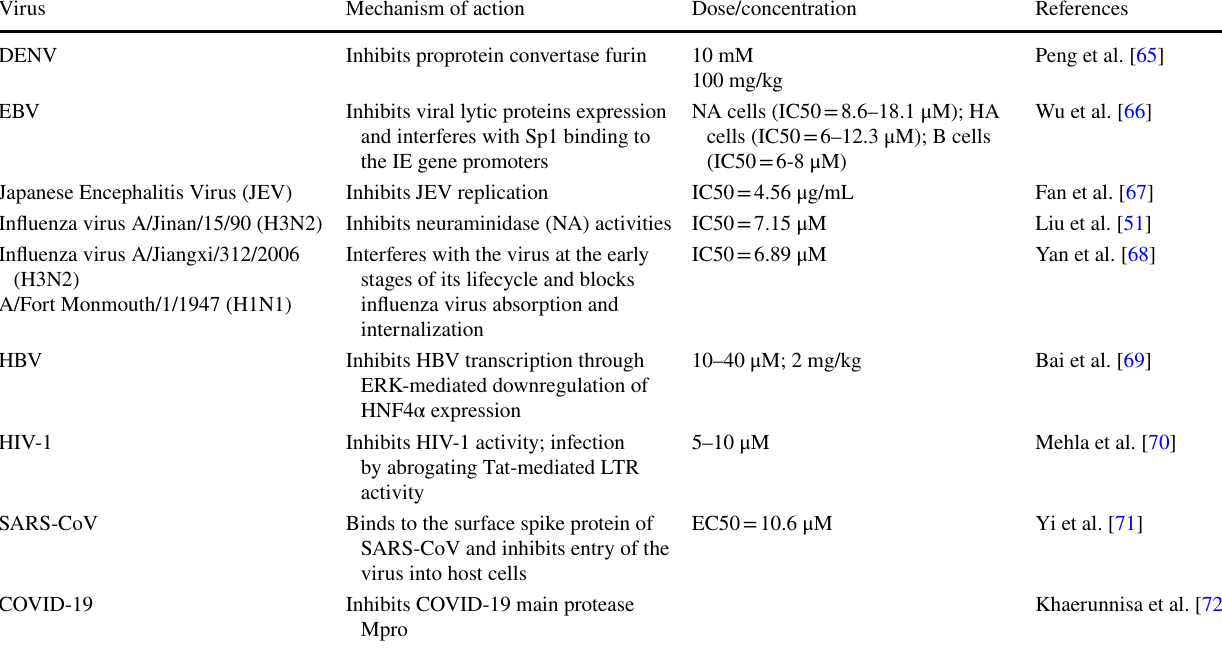
Table 5 Anti-virus activity of luteolin